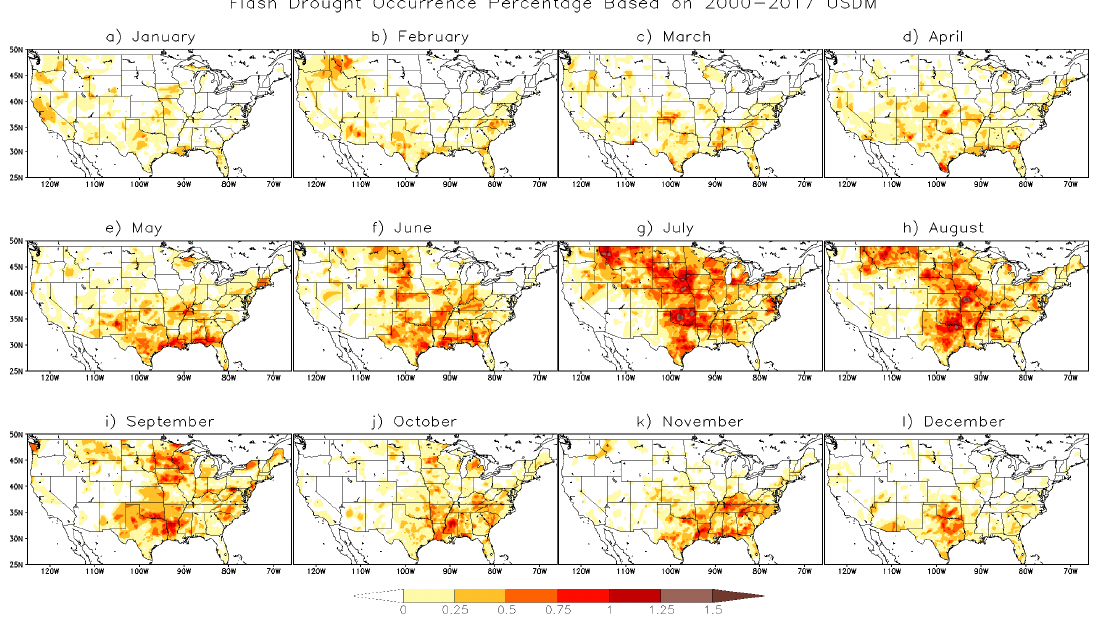
Figure 2. Maps of flash drought occurrence frequency (in percentage) based on rasterized 2000–2017 USDM data for ( a ) January, ( b ) February, ( c ) March, ( d ) April, ( e ) May, ( f ) June, ( g ) July, ( h ) August, ( i ) September, ( j ) October, ( k ) November, and ( l ) December.